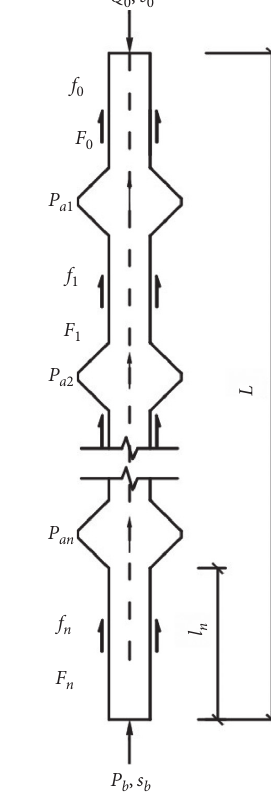
Figure 2: Calculation model of the squeezed branch pile.